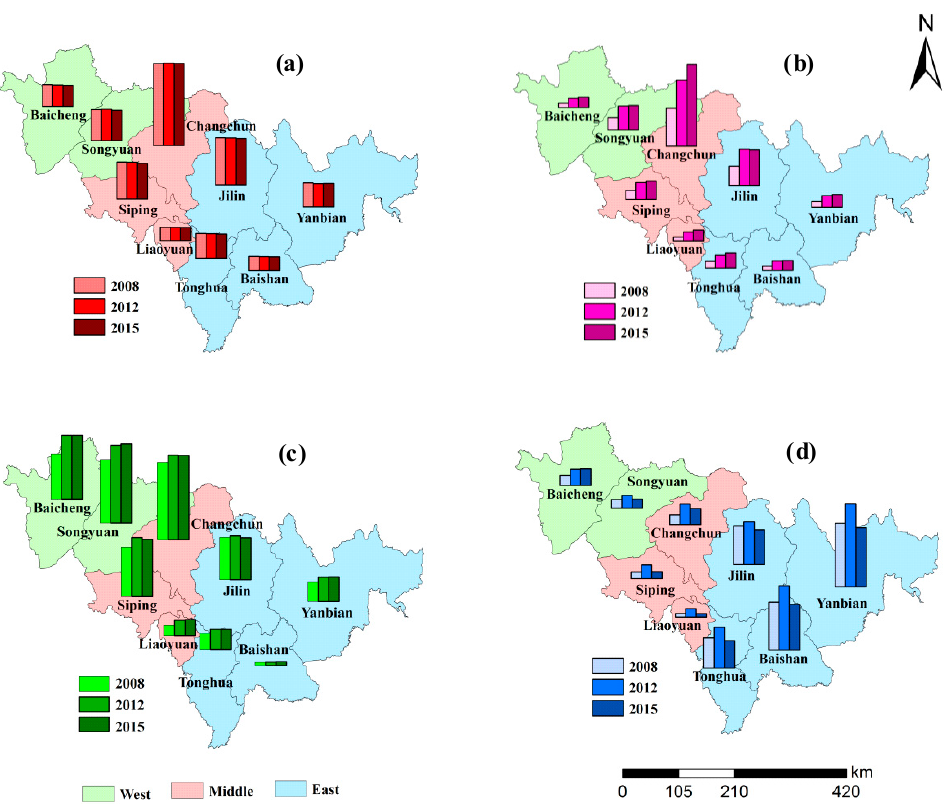
Figure 2. Spatial distributions of population, gross domestic product (GDP), cultivated area, and natural water endowment for nine prefectures in Jilin Province in 2008, 2012, and 2015: ( a ) population (people); ( b ) GDP (10 4 yuan); ( c ) cultivated area (hm 2 ); and ( d ) natural water endowment (10 8 m 3 ).